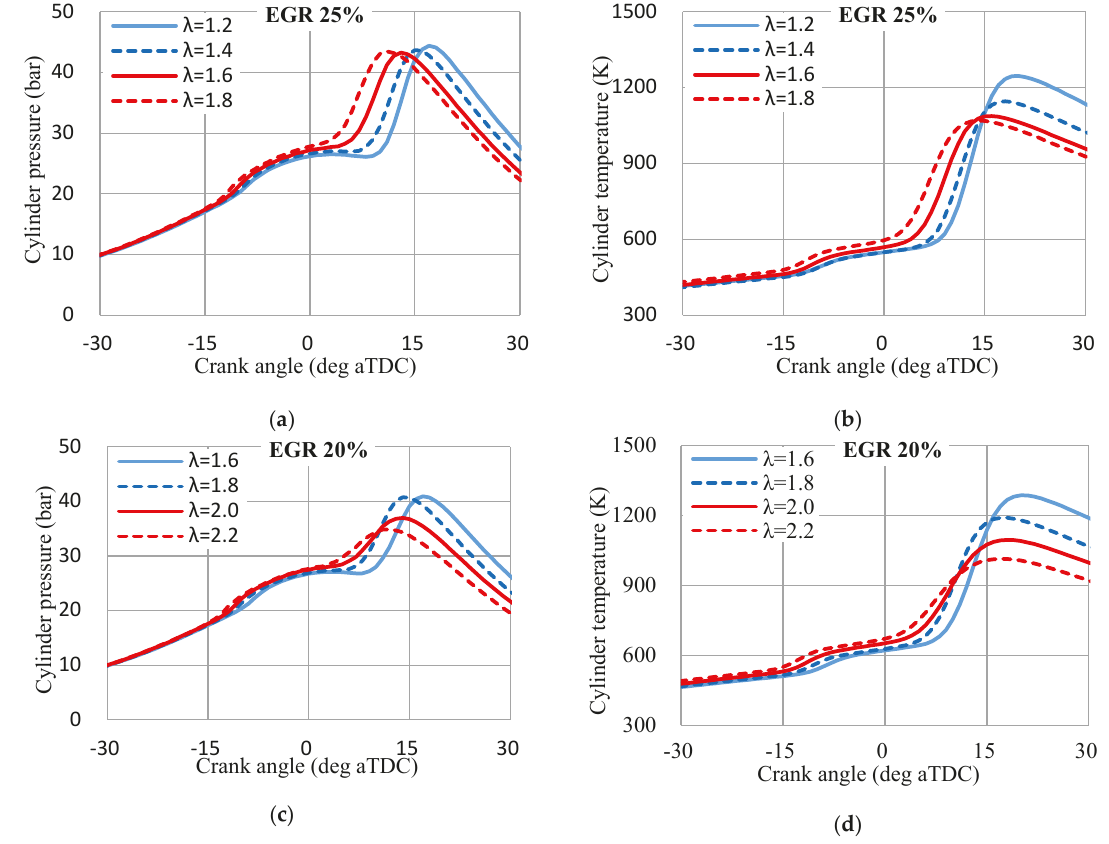
Figure 13. Cylinder pressure and temperature: ( a ) Cylinder pressure with EGR 25%; ( b ) Cylinder temperature with EGR 25%; ( c ) Cylinder pressure with EGR 20%; ( d ) Cylinder temperature with EGR 20%.